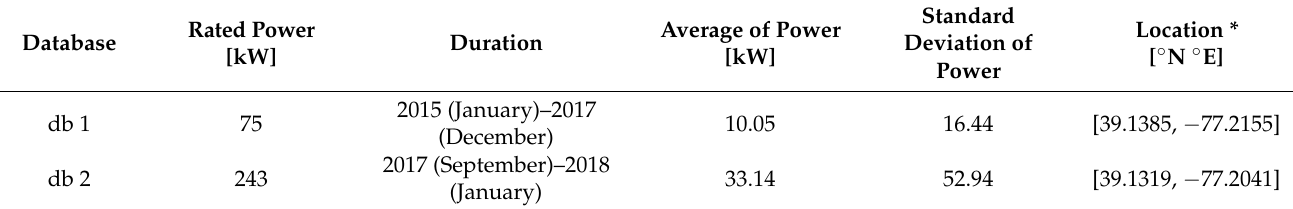
Table 2. Dataset description used in this